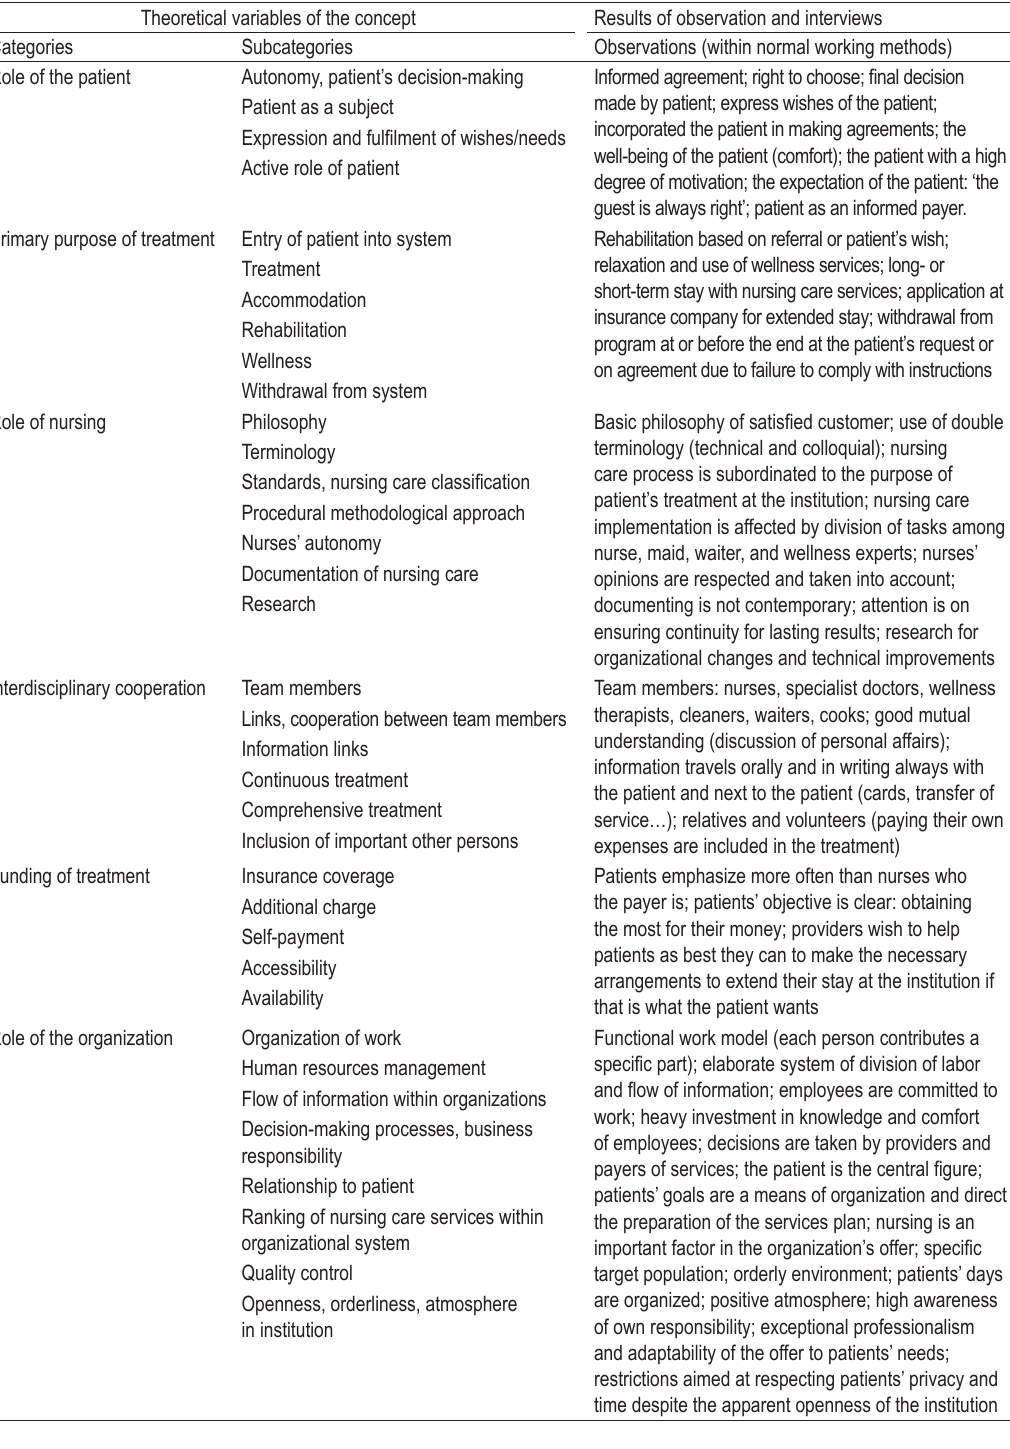
TABLE 1. Theoretical variables and results of observation and interviews Theoretical variables of the